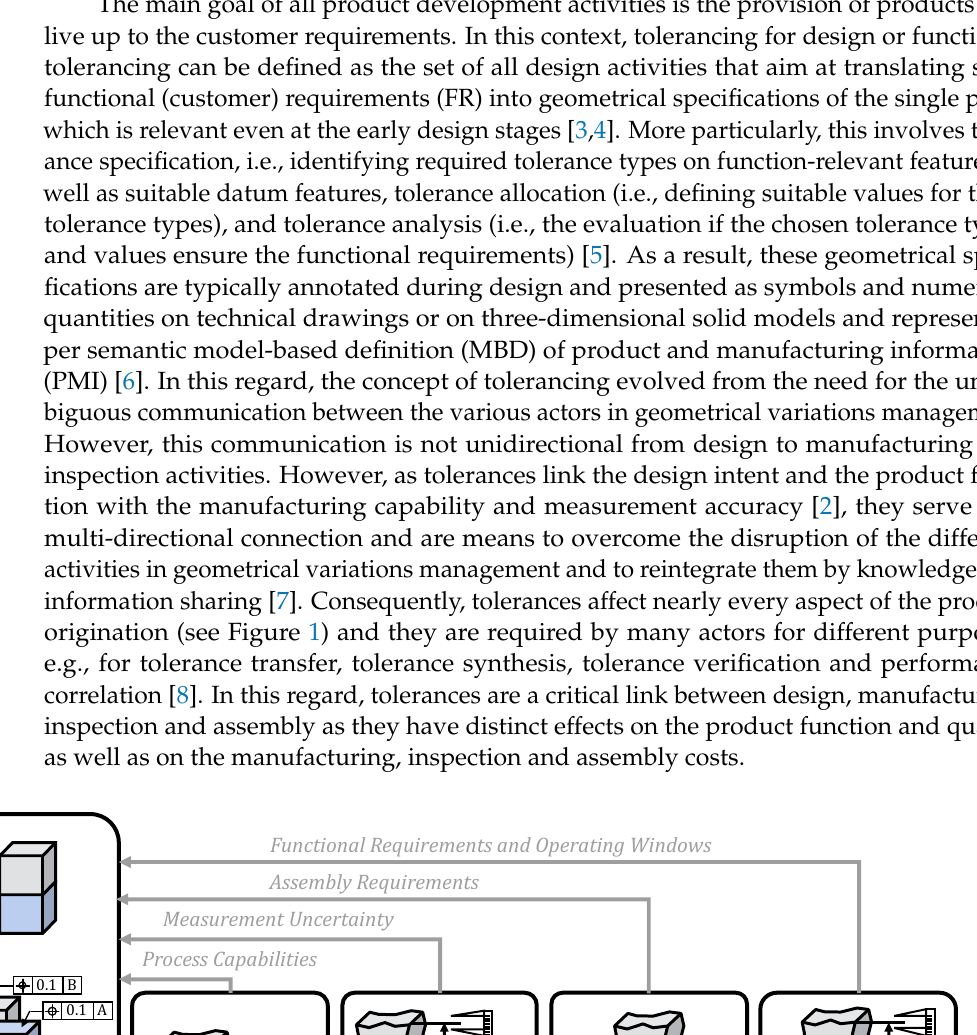
Flat. Dev.: 0.21±0.002 Para. Dev.: 0.47±0.003 Position Dev.: 0.87±0.007